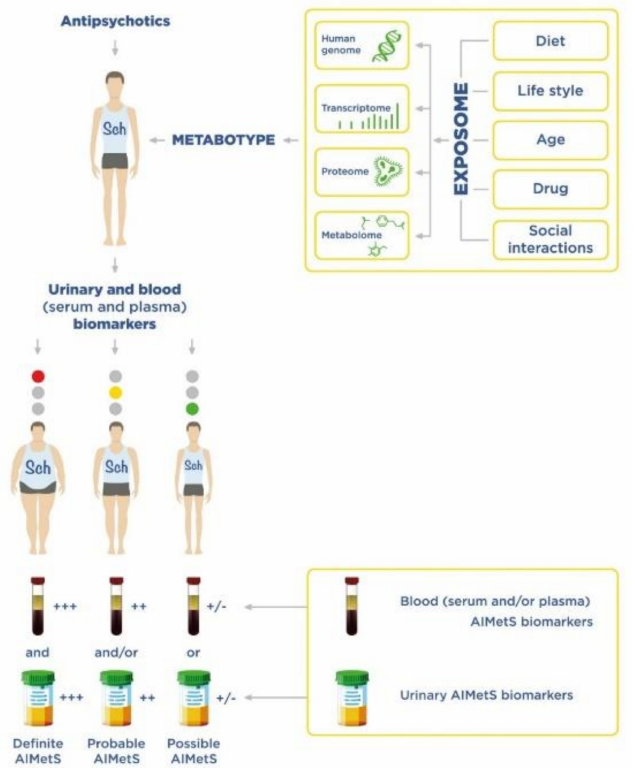
Figure 3. Algorithm of Personalized Approach to the Diagnosis of Antipsychotics—Induced Metabolic Syndrome (AIMetS) in Patients with Schizophrenia (Sch) Based on Blood and Urinary Biomarkers: Definite, Probable and Possible